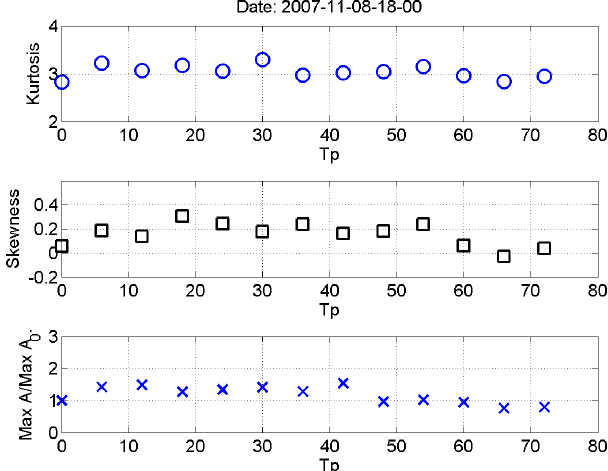
Figure 7. Temporal evolution of skewness, kurtosis and A max / A 0 ( A 0 denotes the initial amplitude used in the simulations while A max is the maximum amplitude (crest)), 8 November 2007,